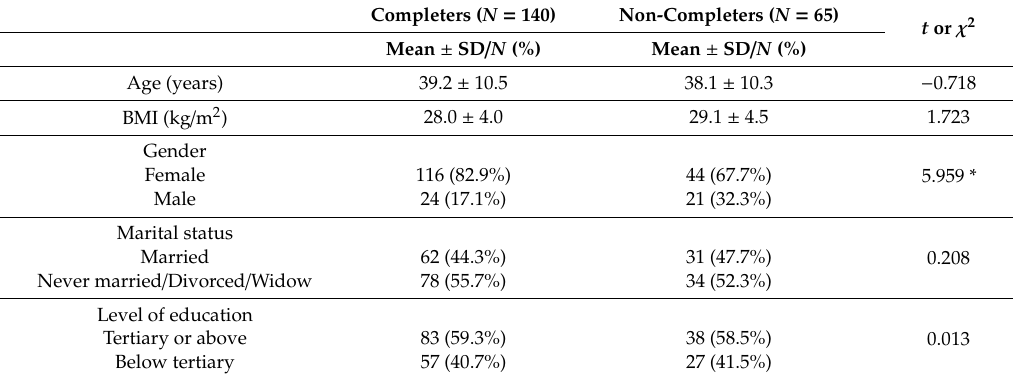
Table 1. Comparison of baseline characteristics between completers and non-completers of the